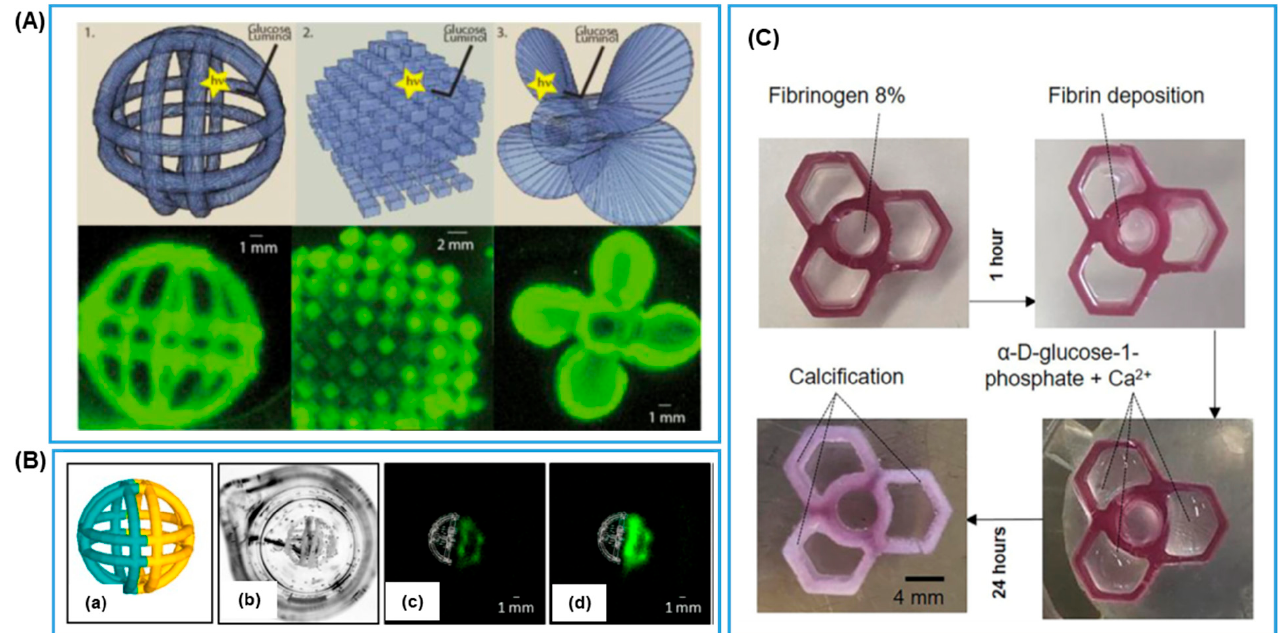
Figure 11. DLP 3D printed PEG-DA based enzyme immobilized hydrogel. ( A ) CAD drawings of complex 3D hydrogel objects entrapping both horseradish peroxidase and glucose oxidase and their chemiluminescent images in the presence of glucose and luminol (reproduced with permission from Ref. [78]). ( B ) Bi-enzyme heterogeneous system: ( a ) CAD drawing of a heterogeneous fanciful ball composed of glucose oxidase ( left ) and peroxidase ( right ); ( b ) visible light image of the printed heterogeneous fanciful ball, and chemiluminescent image of the homogeneous fanciful ball in the presence of glucose and luminol at ( c ) 60 and ( d ) 90 min after substrates addition (From Ref. [47] 2017 MDPI). ( C ) Sequential catalytic activities of thrombin and alkaline phosphatase leading to fibrin deposition and calcification (Reproduced with permission from Ref. [79]).